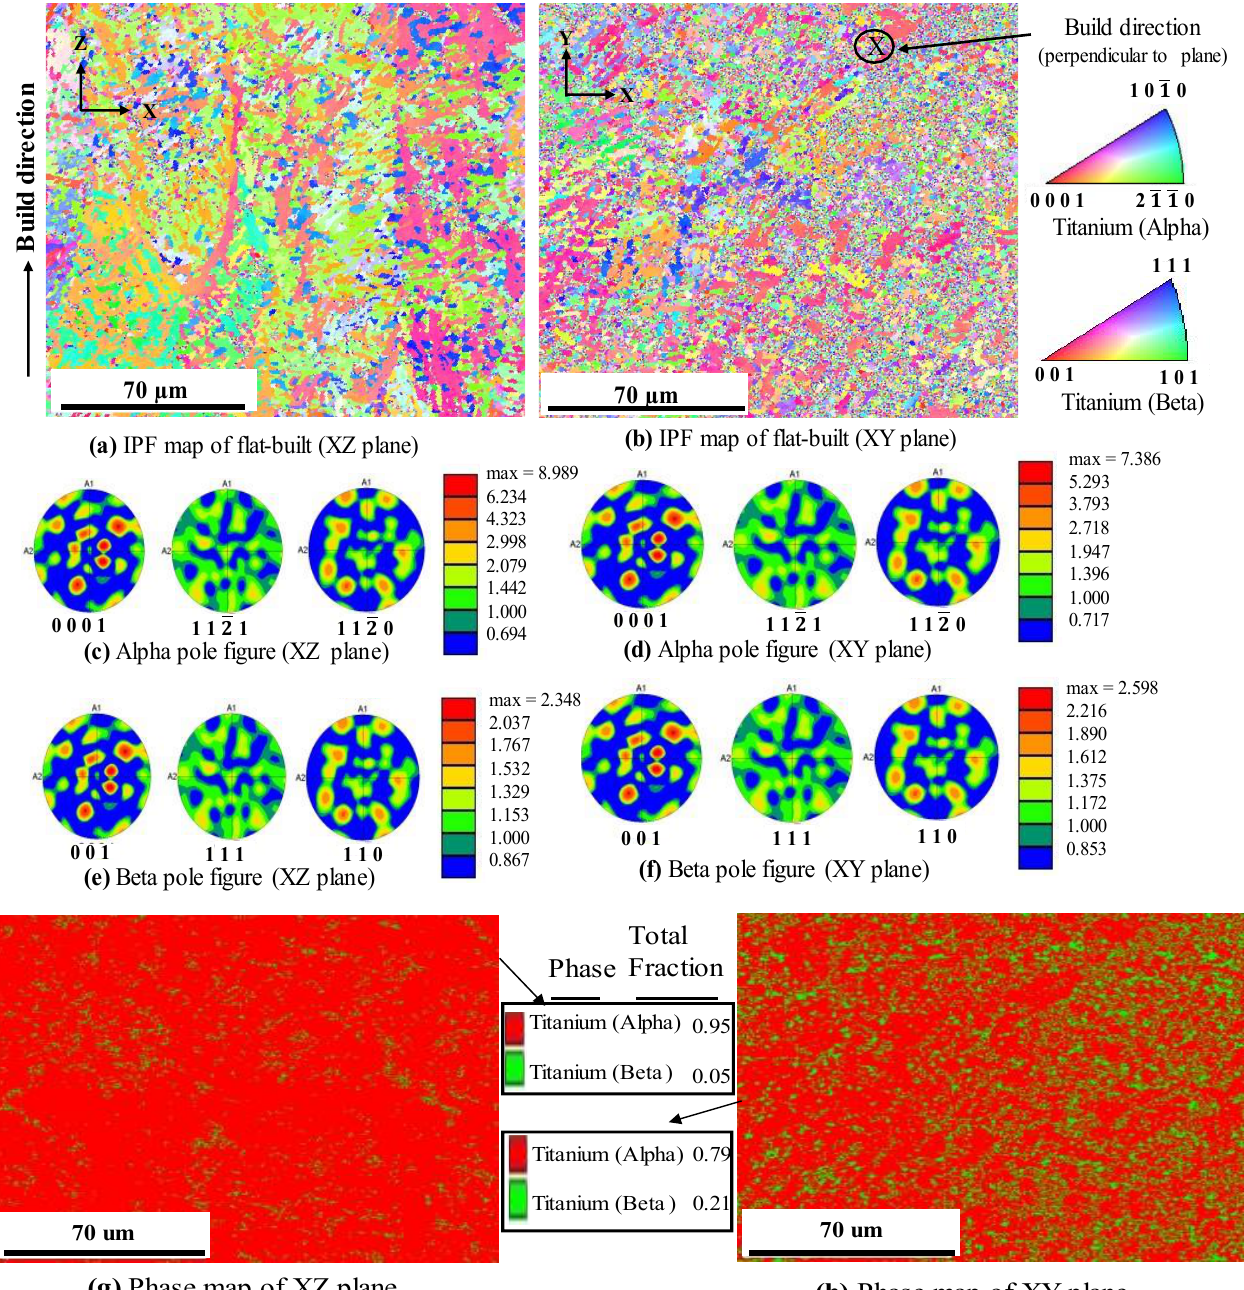
Figure 7. Inverse pole figure (IPF) of the flat-built sample: ( a ) XZ plane showing grains distributed with preferred orientations; ( b ) XY plane showing randomly oriented equiaxed grains, along with alpha pole figure of the harmonic texture of ( c ) XZ plane and ( d ) XY plane; beta pole figure of the harmonic texture of ( e ) XZ plane and ( f ) XY plane, and phase maps ( g , h ) of the two planes.